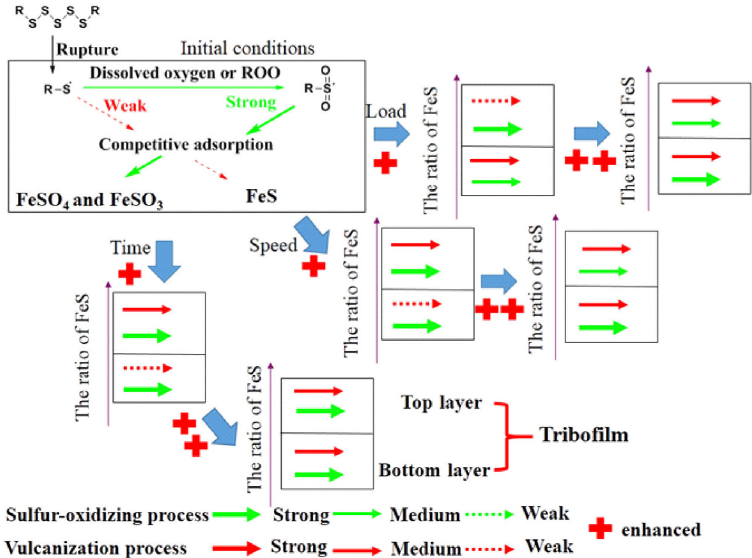
Fig. 6 Schematic explanation of the tribofilm evolution at top and bottom